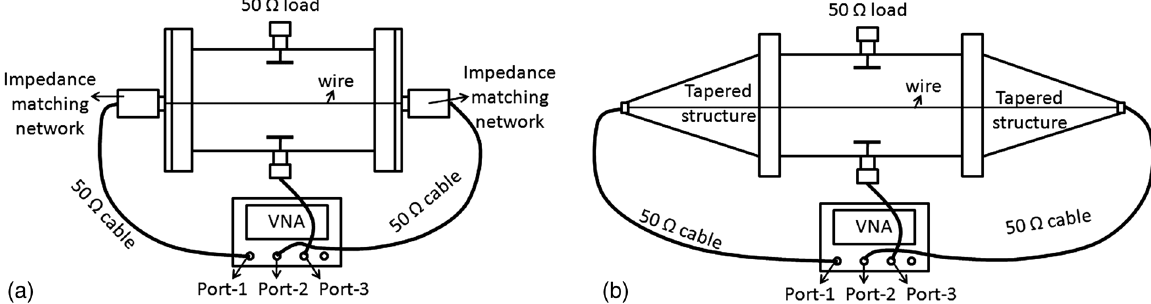
FIG. 1. Schematic setup of the conventional wire method. Impedance matching using electrical network (a) and tapered mechanical structure (b).